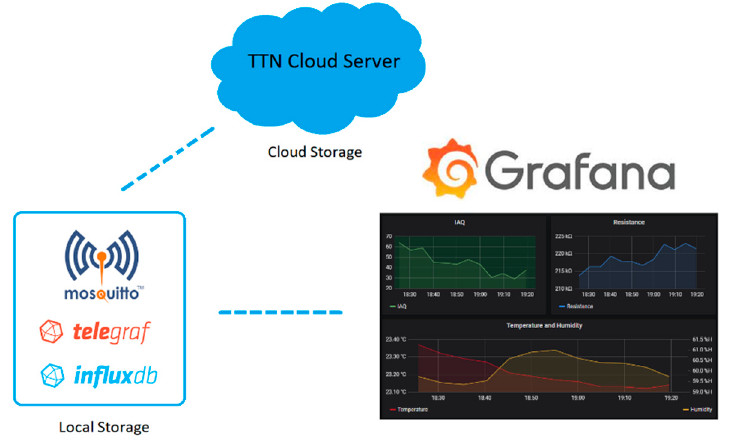
Figure 5. Sensor data path from The Things Network (TTN) cloud server to the front-end application.